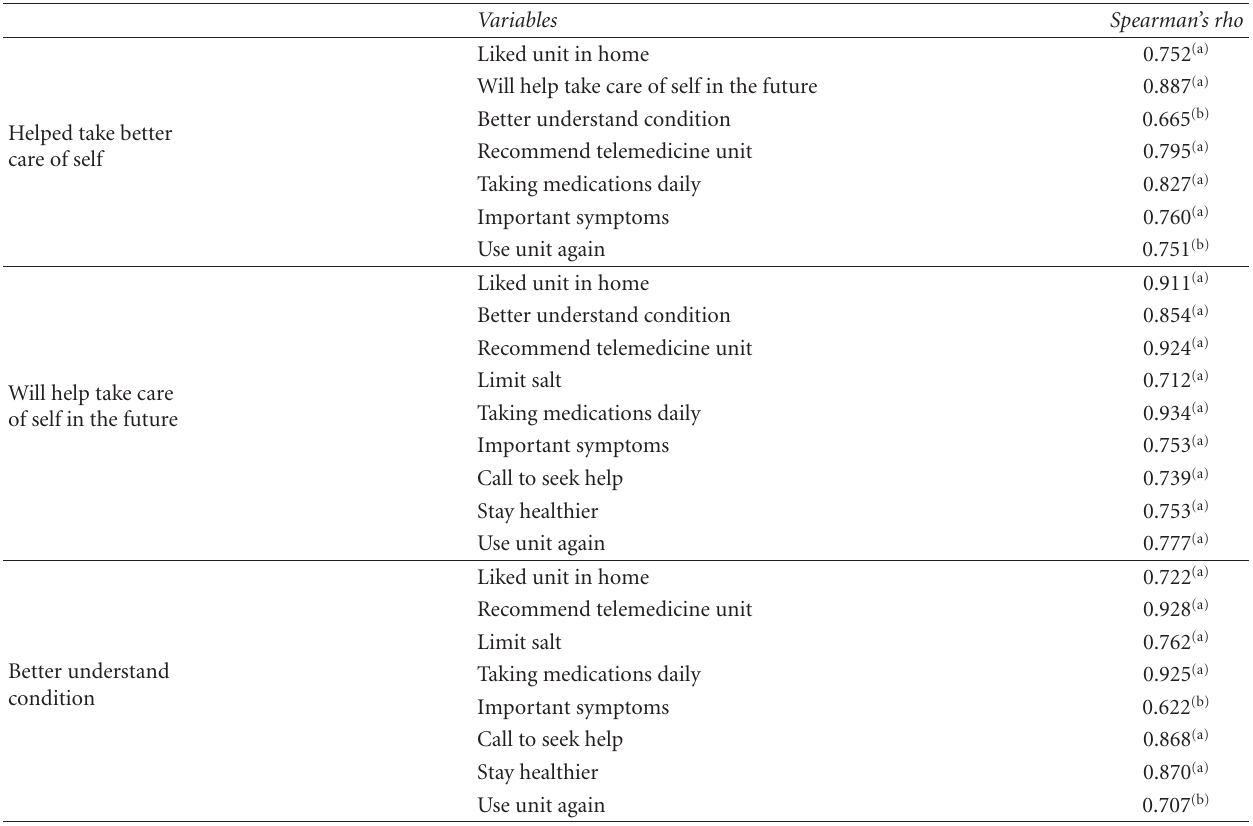
Table 4: Facilitation of self-care